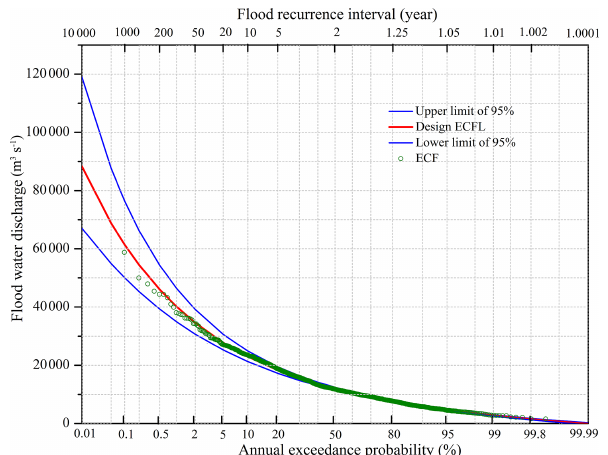
Figure 7. Fitted frequency curves of annual maximum daily dis- charge for the Yalu River based on the GEV statistical method and simulated annual peak flows of the past 1000 years. The blue lines indicate the upper and lower limits of the 95% confidence level, the red line indicates the design empirical cumulative frequency line (ECFL), and the green dots are the empirical cumulative fre- quency (ECF) for annual peak water discharges over the past mil- lennium.